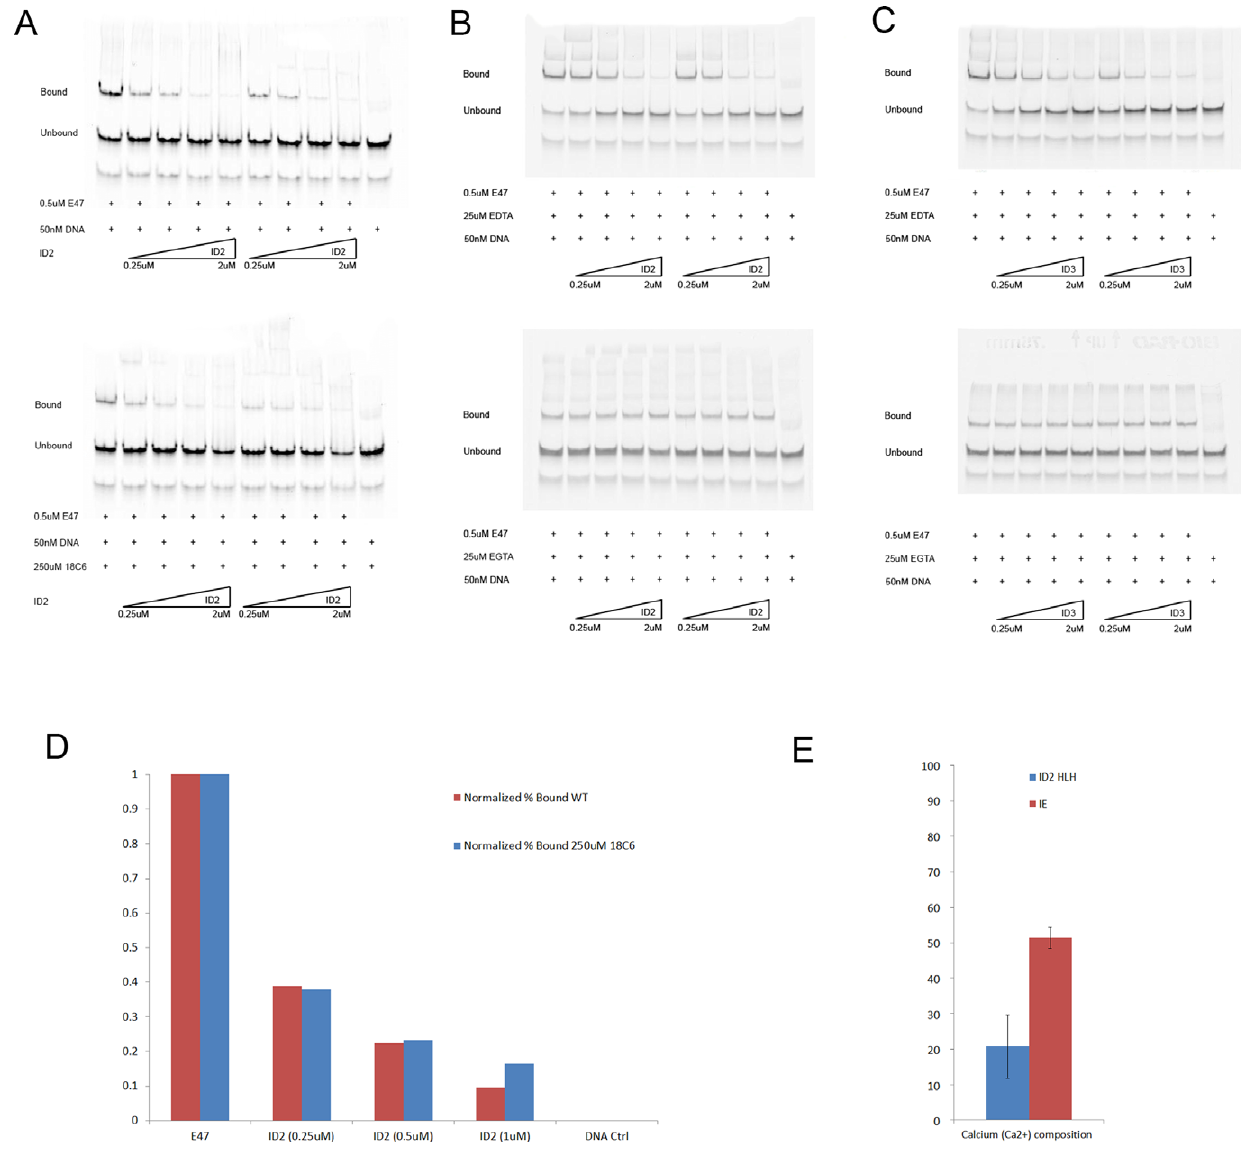
Figure 2. Identification of the positive ion in electrophoretic mobility shift (EMSA) assays. (A) Top: Wild type ID2 titrated against 0.5 uM E47. Bottom: Wild type ID2 titrated against 0.5 uM E47 in the presence of 250 uM 18C6. (B) Top: Wild type ID2 titrated against 0.5 uM E47 in the presence of 25 uM EDTA. Bottom: Wild type ID2 titrated against 0.5 uM E47 in the presence of 25 uM EGTA. (C) A repeat of (B) with ID3 instead of ID2. (D) Normalized quantification (to E47 Control for each lane; see Methods for details) of the ID2-E47 EMSAs in (A). (E) The y-axis represents calcium levels (uM) in ID2 and ID2-E47 complexes (IE), tested using the AbcamColormetric Calcium Detection Kit (See Methods), with 400 uM protein sample concentrations.